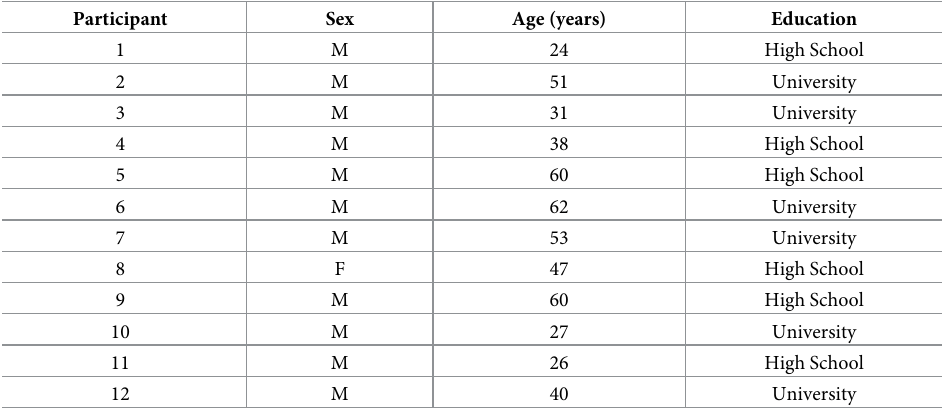
Table 2. Control group: Demographic